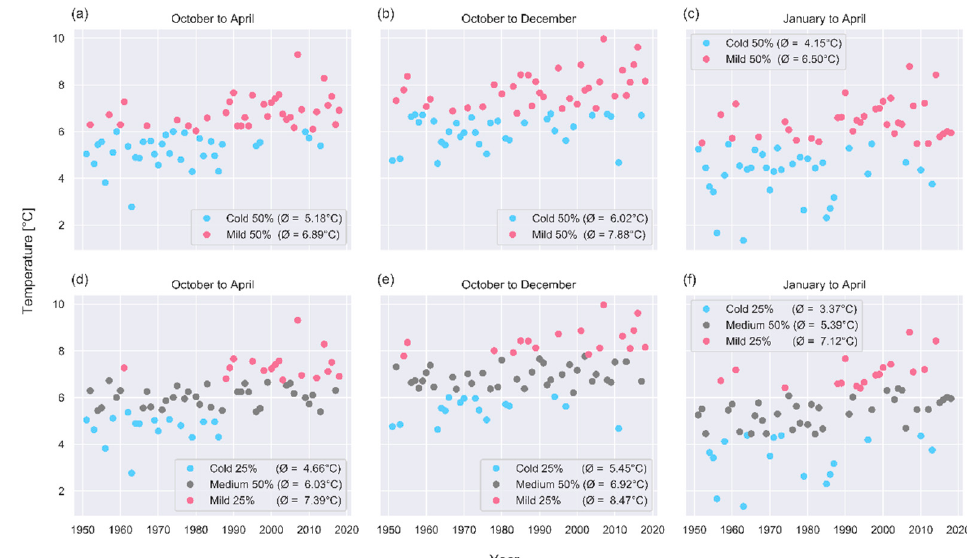
Figure 2. Average daily temperatures during the ‘full dormancy’ period (panels ( a , d )), the approximate chilling period (panels ( b , e )), and forcing periods (panels ( c , f )) studied either after segmentation in halves (34 years each, upper row) or in three parts (17–34–17 years each, lower row). Average temperature refers to daily average air temperature measured at 2 m height during the indicated months at the study site.